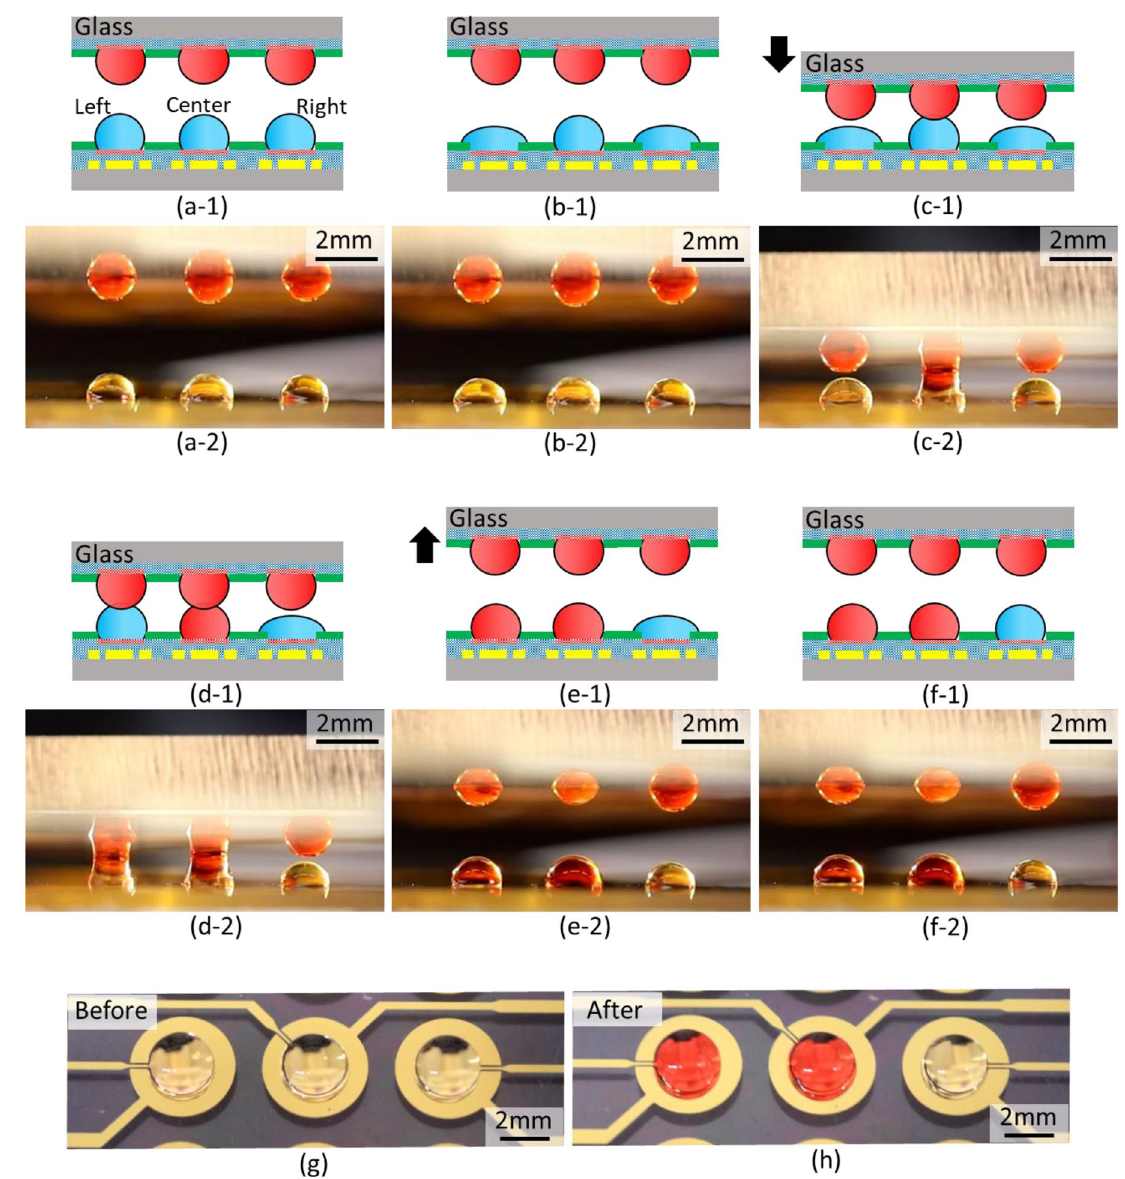
Figure 8. Demonstration of selective control of contact and transport for droplet-array sandwiching technology. ( a ) Three droplets of the red dye compound new coccine are prepared on the upper device whereas three droplets of DI water are prepared on the lower device. The volume of each droplet is assumed to be 4 μl. ( b ) Two droplets at both ends on the lower device are lowered by applying voltage whereas the central droplet maintains its initial height. ( c ) The position of the upper device is lowered to move individual droplet pairs closer together in the vertical direction. The droplet pairs at both ends do not contact yet when the central droplet pairs come into contact and fuse. New coccine is transported between the central droplet pairs. ( d ) The height of a droplet at the left end on the lower substrate is reverted by turning the applied voltage off. The droplet pairs at the left end come into contact and fuse. New coccine is transported between the left droplet pairs. ( e ) The position of the upper device is raised to separate the contact of droplet pairs. ( f ) The applied voltage to the droplet at the right end on the lower substrate is then turned off. Contact and transport do not occur between the droplet pairs at the right end. ( g ) Top view of an initial state of droplets on the lower device in ( a ). ( h ) Top view of a final state of droplets on the lower device in ( f ). Selective control of contact of the droplet pairs and transport of substances by EWOD are successfully